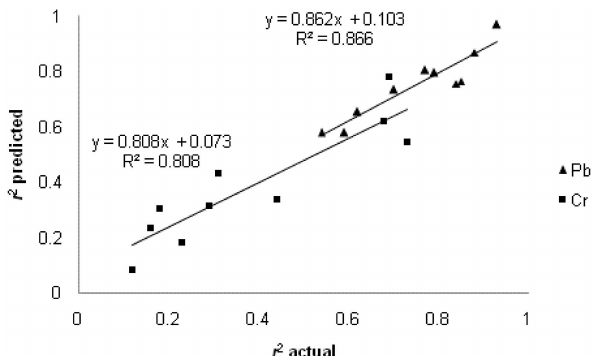
Figure 4. Actual variance explained by the common model or each site versus predicted Fig. 4. Actual variance explained by the common model or each variance based on SO4 and Silva (Pb) or Si and Alt (Cr). Ringsmobäcken was excluded from site versus predicted variance based on SO 4 and Silva (Pb) or Si the analysis. and altitude (Cr). Ringsmob¨acken was excluded from the analysis.